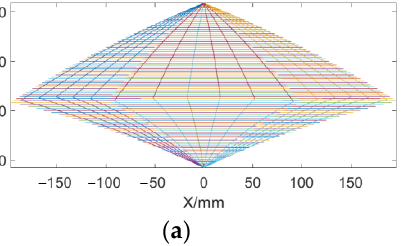
Figure 15. Projection of the workspace on the xoz plane: ( a ) Before optimization; ( b ) After optimization.